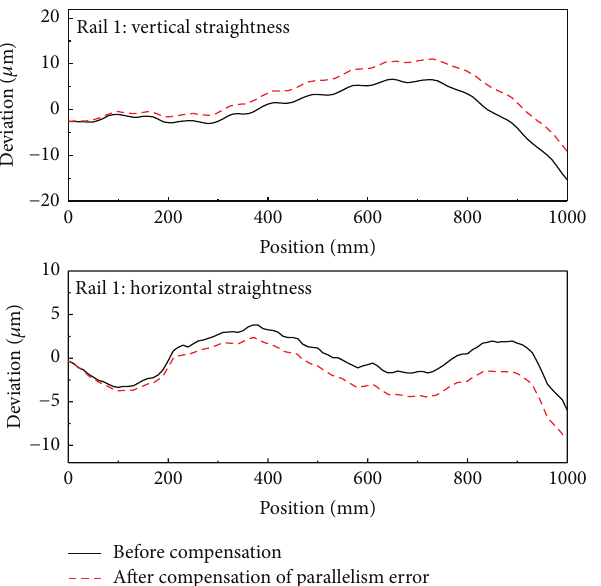
Figure 15: The straightness error of the bearing block for each